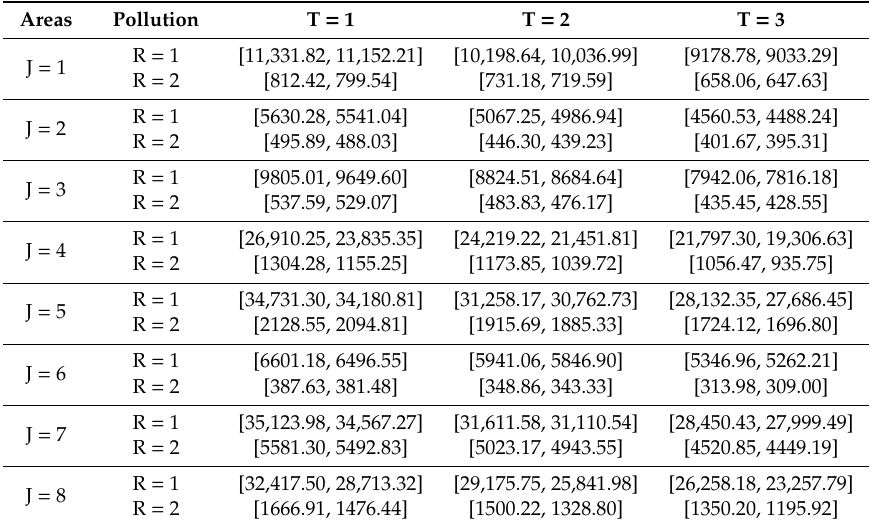
Table 3. The range of the maximum total amount of pollutants in area j during the period t (tons / year). Areas